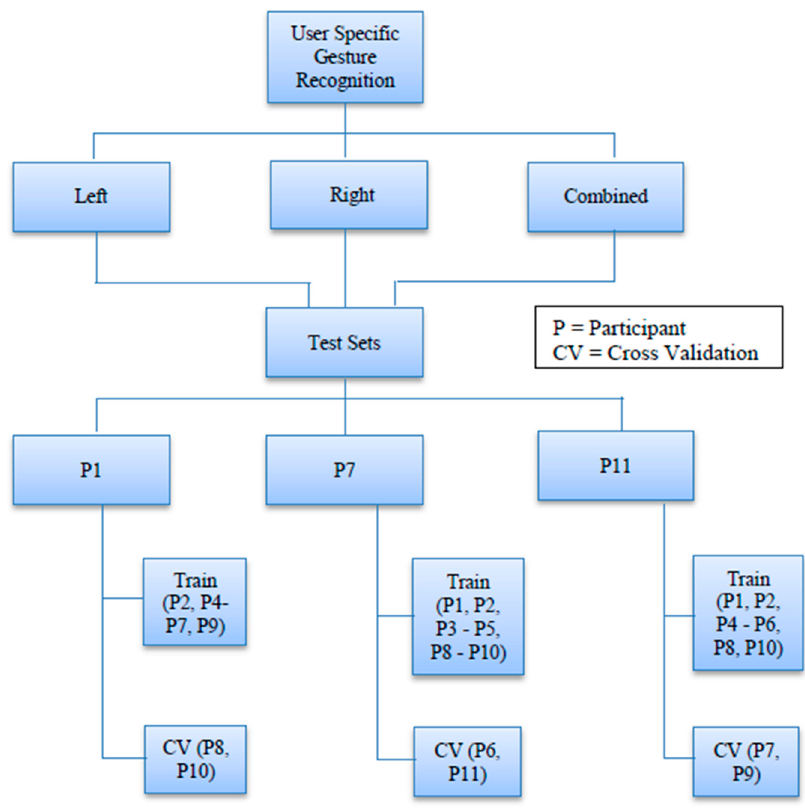
Figure 9. Dataset splits for User Specific Gesture Recognition.